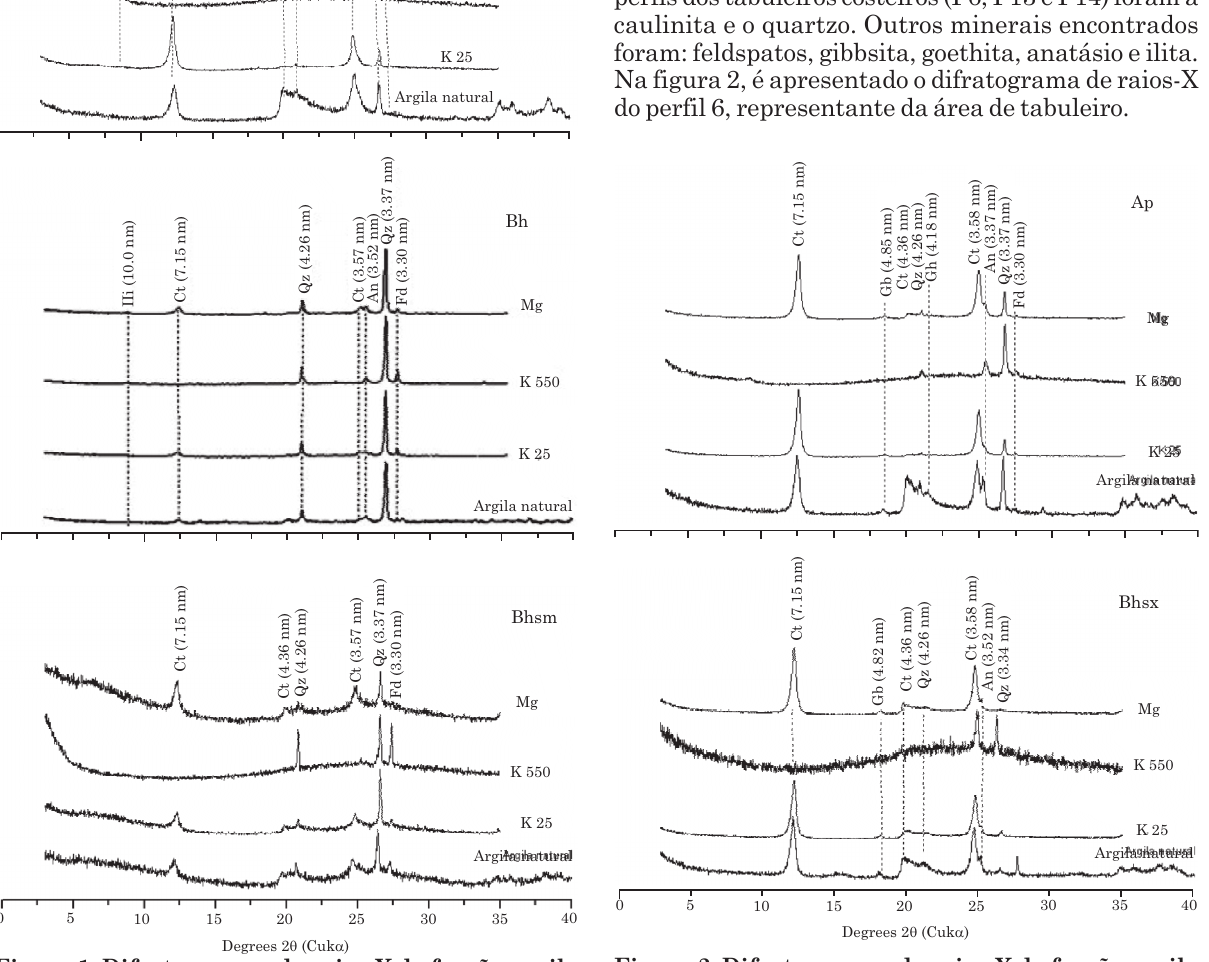
Figura 2. Difratogramas de raios-X da fração argila dos horizontes Ap e Bhsx, do perfil 6. An: anatásio; Ct: caulinita; Fd: feldspato; Gb:gibbsita; Gh: goethita; e Qz: